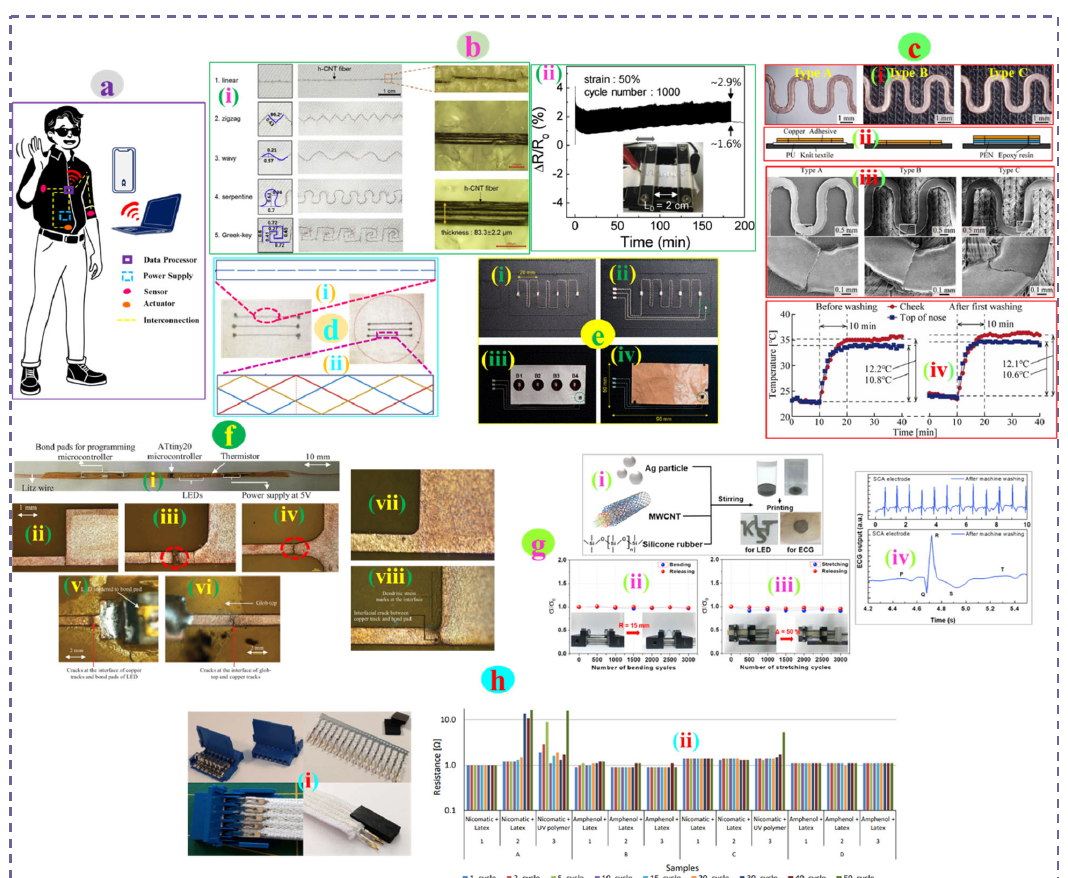
Figure 6. ( a ) Basic architecture of a wearable electronic textiles system embedded with different functional units interconnected together. ( b ) Different interconnection patterns made of hybrid CNT fibers (i) and (ii) cyclic stability of the serpentine pattern under 50% strain. Reproduced with permission [200] Copyright 2019, Elsevier. ( c ) (i) Optical images of the differently attached serpentine interconnect on the knit substrate, (ii) Cross-section and (iii) SEM images for each type of attachment upon cyclic deformation, (iv) variations in temperature before and after the first washing. Reproduced with permission [201] Copyright 2021, Institute of Physics. ( d ) Interconnection pattern made by single-line stitch sewing (i) and three-line stitch embroidery (ii). Reproduced with permission [202] Copyright 2020, Elsevier. ( e ) One-stop production of a four-button touch sensor. (i) Embroidery of the sensing pattern using Ag coated PA yarn, (ii) Embroidered metal composite yarn circuit for interconnections, (iii) placement of mesh spacer insulation layer, and (iv) attachment of upper conductive layer in the assembly by normal yarn satin stitch. Reproduced with permission [203] Copyright 2017, Sage Publications. ( f ) Different components attached to the filament using solder paste (i), post-bending failure of the copper tracks with no fillet (ii), filleted at the edge (iii), and center of the bond pad (iv), failure of the copper tracks upon bending without (v) and with glob-top encapsulation (vi), optical images of the circuit before (vii) and after washing (viii). Reproduced with permission [204] Copyright 2019, Wiley. ( g ) Schematic of the stretchable conductive adhesive (SCA) paste preparation (i), change of conductivity upon cyclic bending (ii) and stretching (iii), ECG output of SCAs as electrodes at machine washing (iv). Reproduced with permission [205] Copyright 2019, ACS publications. ( h ) (i) images of Amphenol and Nicomatic Crimp, (ii) resistance of different crimp interconnects after 50 cycles of washing. Reproduced with permission [206] Copyright 2021,